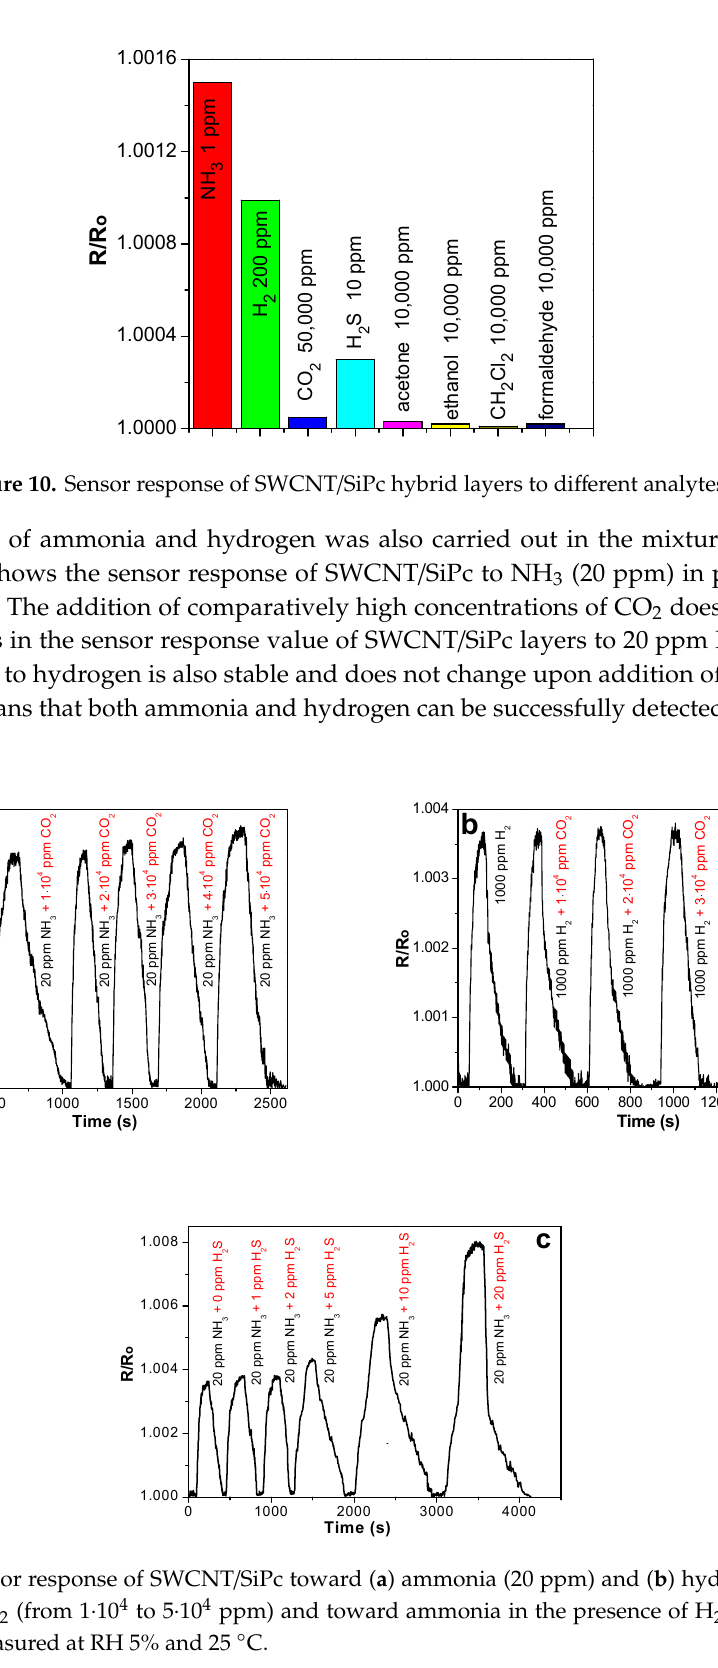
Figure 11. Sensor response of SWCNT / SiPc toward ( a ) ammonia (20 ppm) and ( b ) hydrogen in the presence of CO 2 (from 1 · 10 4 to 5 · 10 4 ppm) and toward ammonia in the presence of H 2 S (from 1 to 20 ppm) (c) measured at RH 5% and 25 °C.